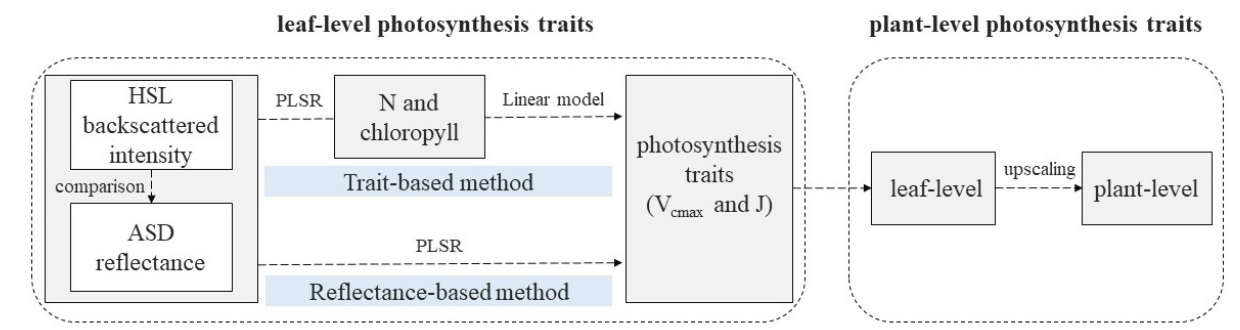
Figure 2. Workflow of data processing.